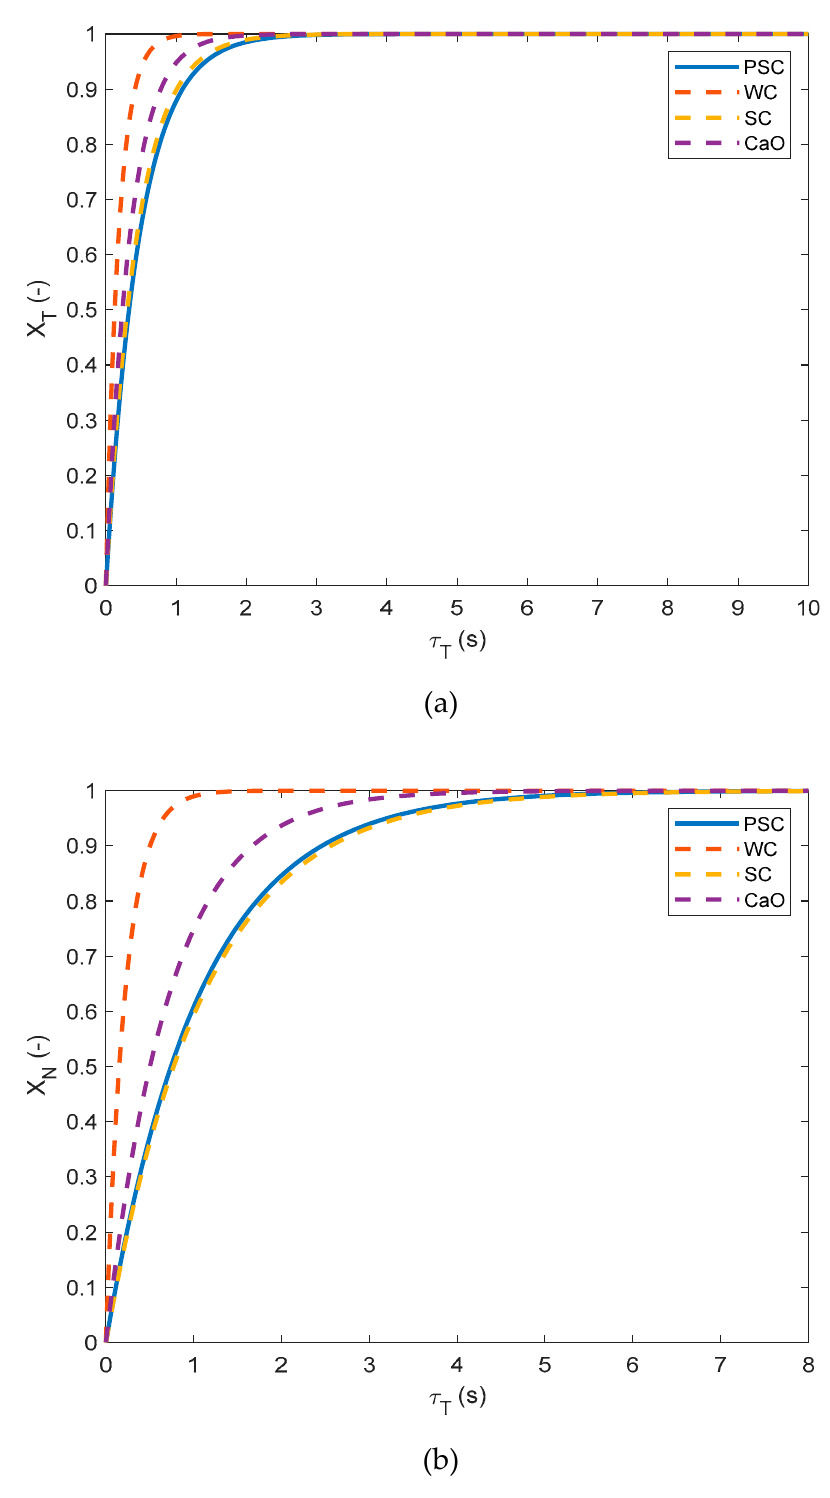
Figure 11. ( a ) Toluene; and ( b ) naphthalene conversion as a function of theoretical residence time at 850 °C for different active materials.